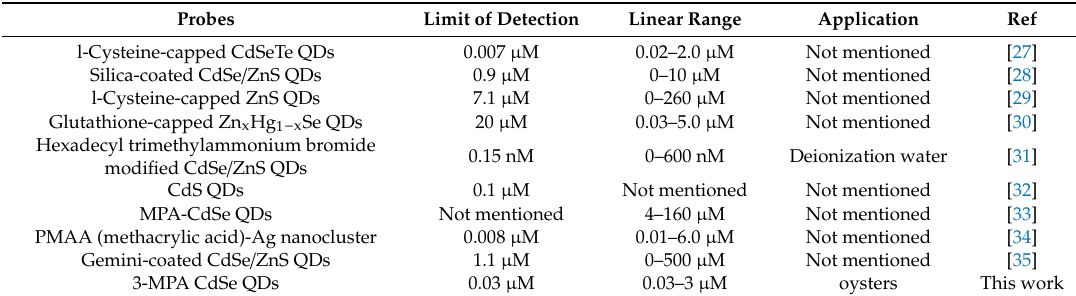
Figure 3. CdSe QDs were used for the detection of Cu 2+ in aqueous solution. ( a ) Fluorescence intensity of CdSe QDs was measured after adding different concentrations of Cu 2+ . ( b ) Fluorescence quenching efficiency of CdSe QDs was detected with different concentrations of Cu 2+ . F 0 is the fluorescence intensity of pure CdSe QDs. F is the fluorescence intensity of CdSe QDs as Cu 2+ was added with different concentrations. ( F 0 − F )/ F 0 is the fluorescence quenching efficiency of CdSe QDs. Table 2. Comparison of Cu 2 + sensors reported by